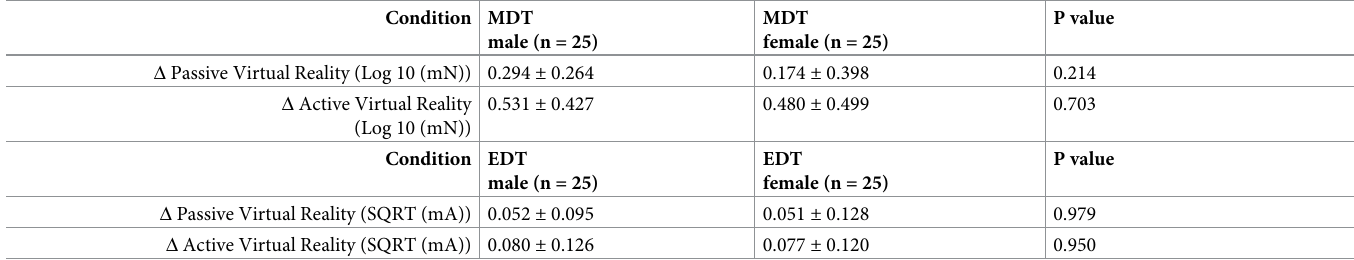
Table 1. Gender differences in monofilament detection thresholds (MDT) and electrical detection thresholds (EDT) (Mean ±